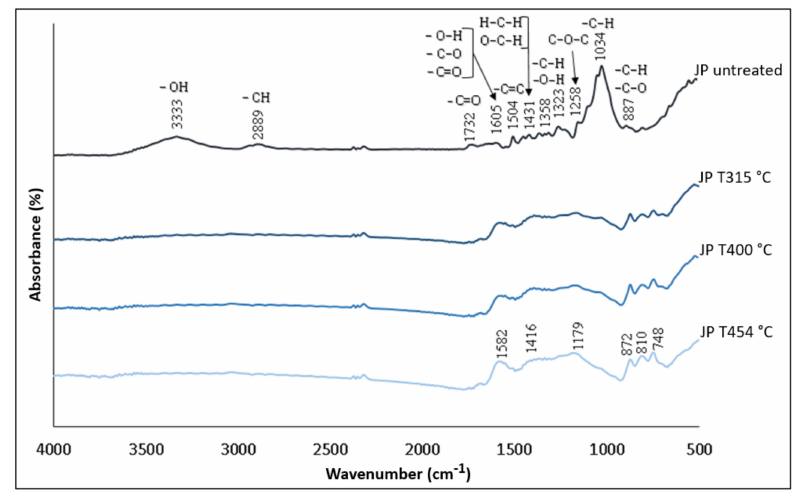
Figure 3. FTIR spectra of jack pine pellets at different heat temperatures.